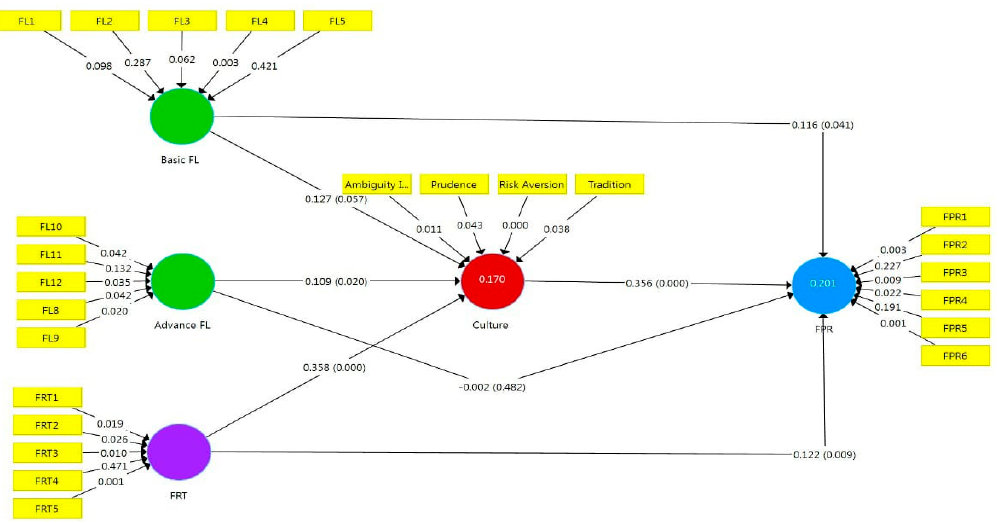
Figure 2. Hypothesis Testing: Bootstrapping Direct and Indirect Effect Results.